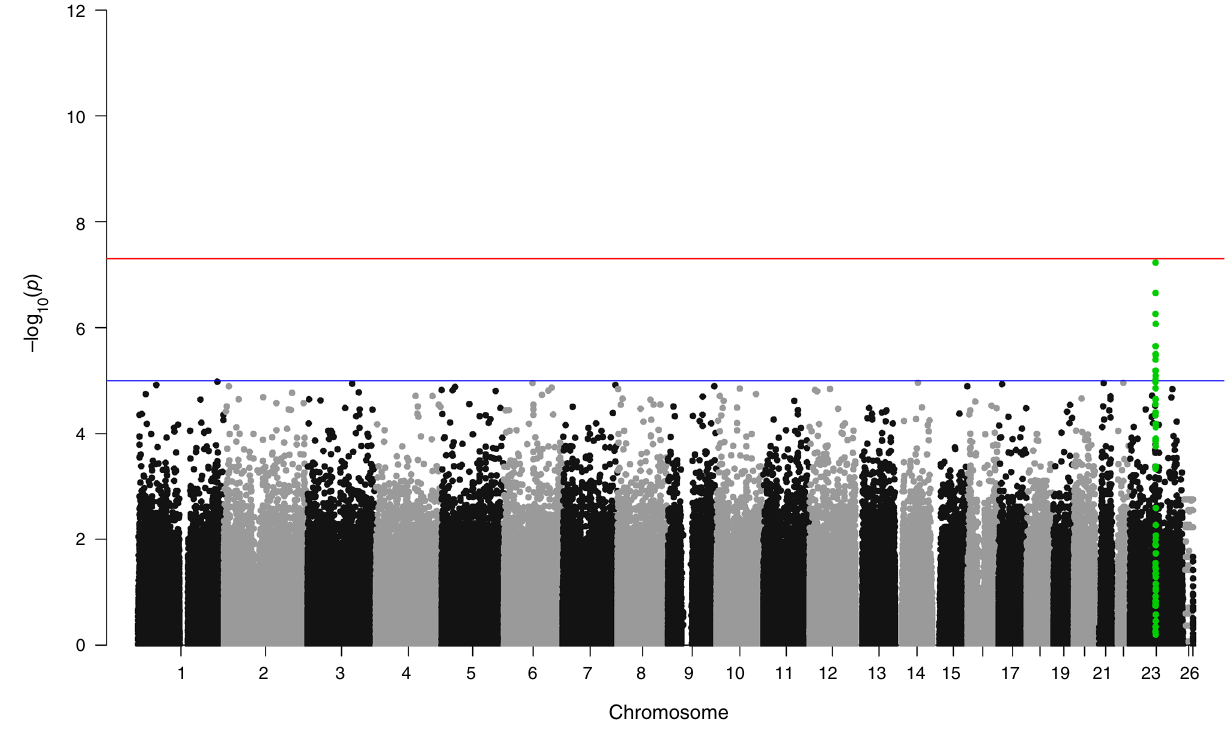
Figure 1. Manhattan plot. Genome-wide association results for aldosterone-producing adenomas (APAs). Manhattan plot of P values in –log 10 scale from the logistic regression with sex as a covariate on 727,307 SNPs (from 33 cases and 58 controls). The horizontal lines indicate the genome-wide significance threshold (red line = 1X10 –8 , blue line = 1X10 –6 ). Green dots show the 100 most significant SNPs in the region of the susceptibility